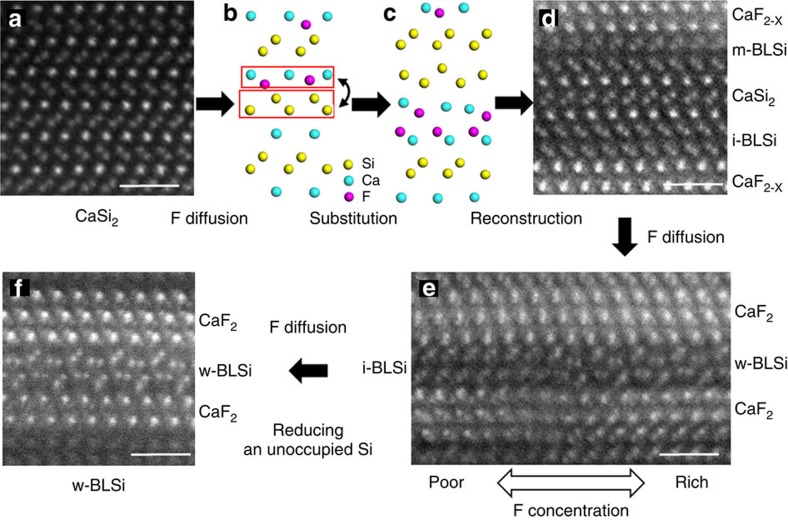
A model for the transformation process from monolayer Si to w-BLSi.(a) and (d–f) HAADF-STEM image. (b,c) A schematic model. (a) Raw tr6 CaSi2. (b) F diffusion into CaSi2. (c) A random arrangement of i-BLSi and bilayer CaF2-X in CaSi2. (d) i-BLSi, CaF2-X and CaSi2 in a region with CaSi2F0.6-1.0. (e) i-BLSi and w-BLSi formed within the same layers in CaSi2F0.6-1.0. (f) w-BLSi in CaSi2F2.0. All scale bars, 1 nm.